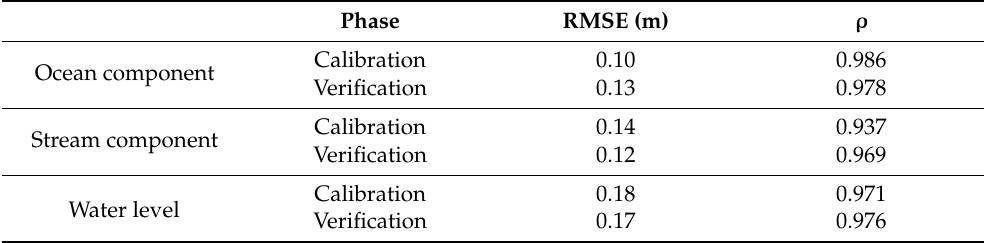
Table 4. Summary of performance metrics carried out by comparing observations and